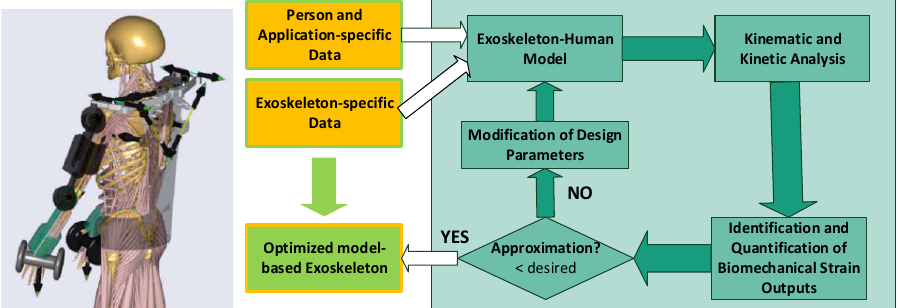
Figure 6. Exoskeleton–human model in AnyBody Modeling System (AMS) and model-based optimization loop. The optimization loop describes the different steps of implementing person and application-specific information as anthropometric, motion and force data. Further, an exoskeleton– human model in AMS is built to compute kinematic and inverse dynamic analysis to identify and quantify biomechanical output values. Compared with recommended ergonomic strain limit values, it is decided whether to abort or to continue with modifications of the any design parameters. The left exoskeleton–human model visualizes the Stuttgart Exo-Jacket, a potential supportive vest for manual carrying, holding and lifting tasks.